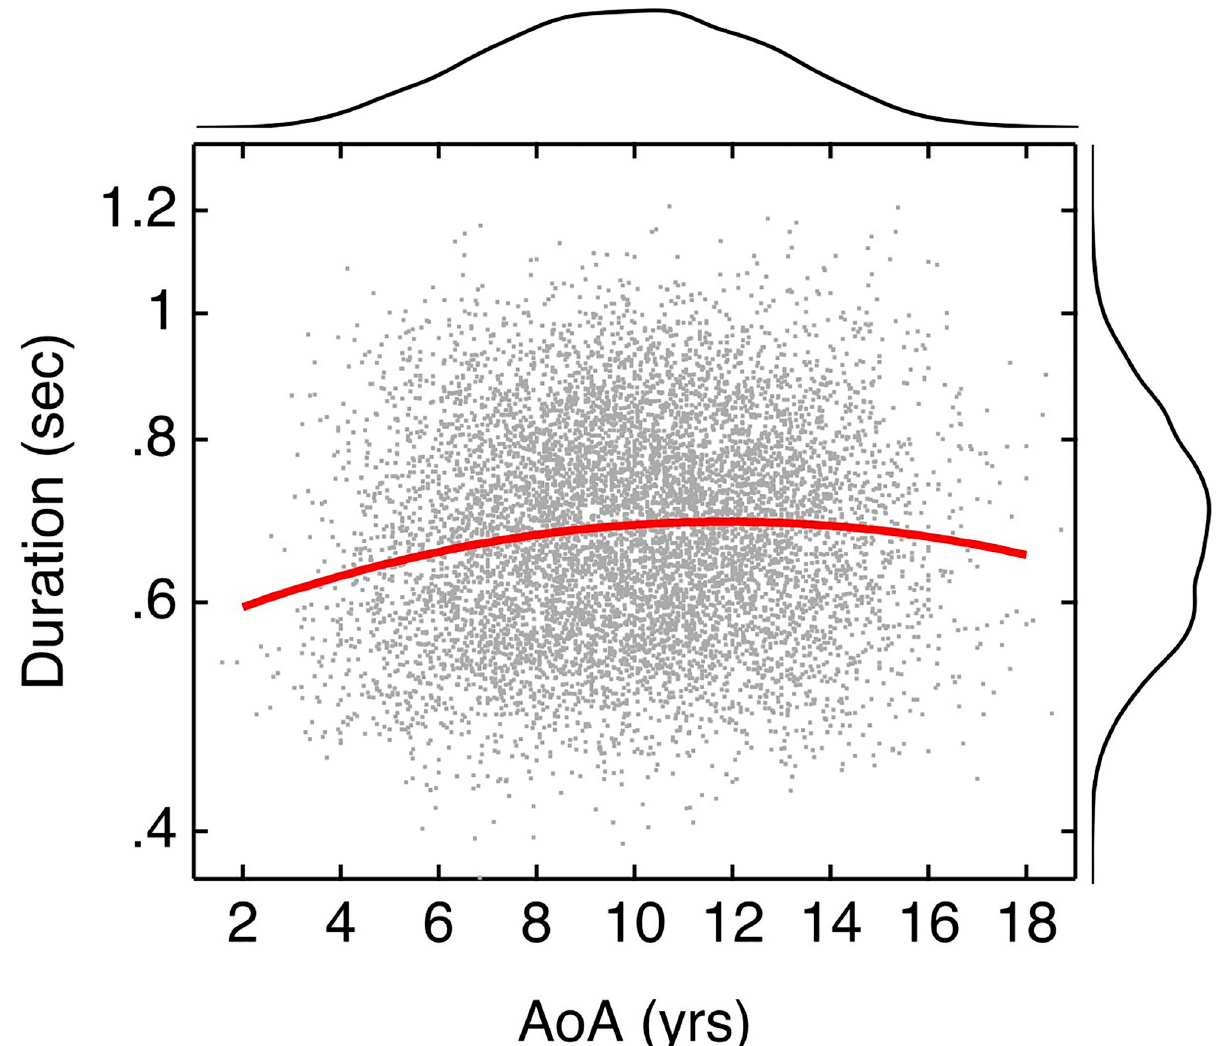
Fig 3. Word duration in sec as a function of AoA. Word duration was estimated using text-to-speech synthesis for two-syllable words from the Kuperman database. Those estimates of duration in seconds are plotted as a function of AoA in years, shown with grey dots. A three-parameter line fit is shown in red, indicating modest increase in duration with increasing AoA up to 12 years, followed by modest reductions in duration thereafter. The distributions of duration and AoA are indicated in the right and top margins,